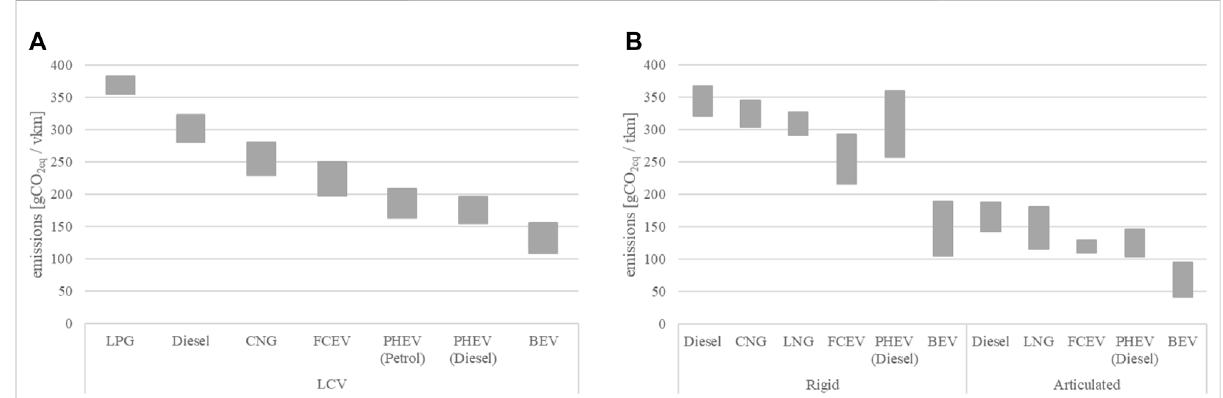
FIGURE 3 LCA emissions, by powertrain: LCV (A) and HCV (B) . Note: the top of the bar re fl ects 2020 values while the bottom the 2030 values. Both are based on the baseline scenario (see the original source for details, including assumptions and additional results). Source: adapted from data in EC